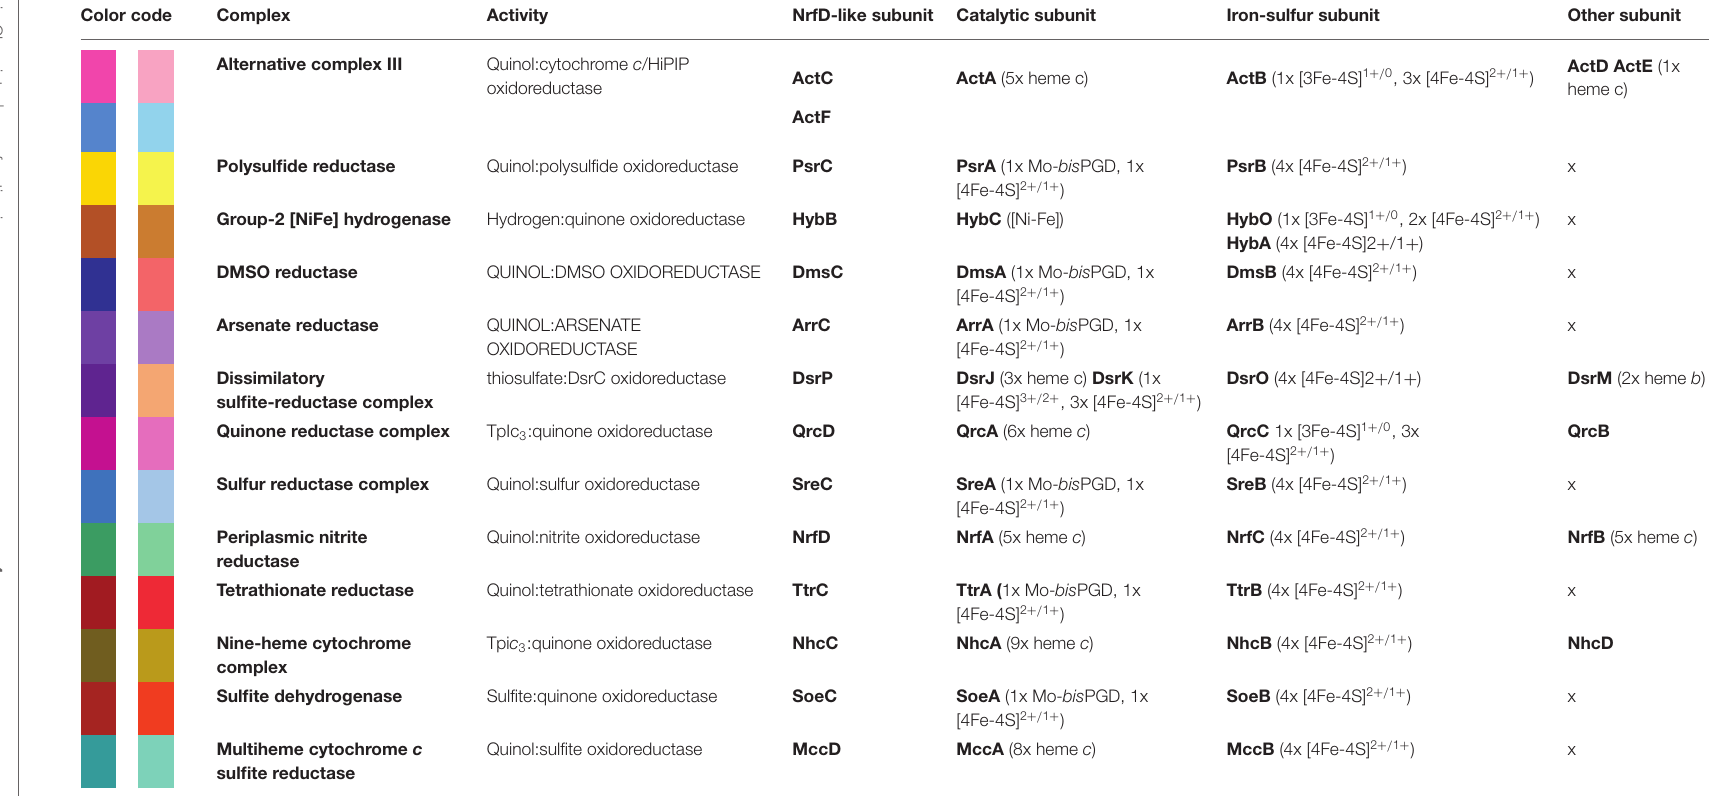
TABLE 1 | NrfD-like subunit-containing